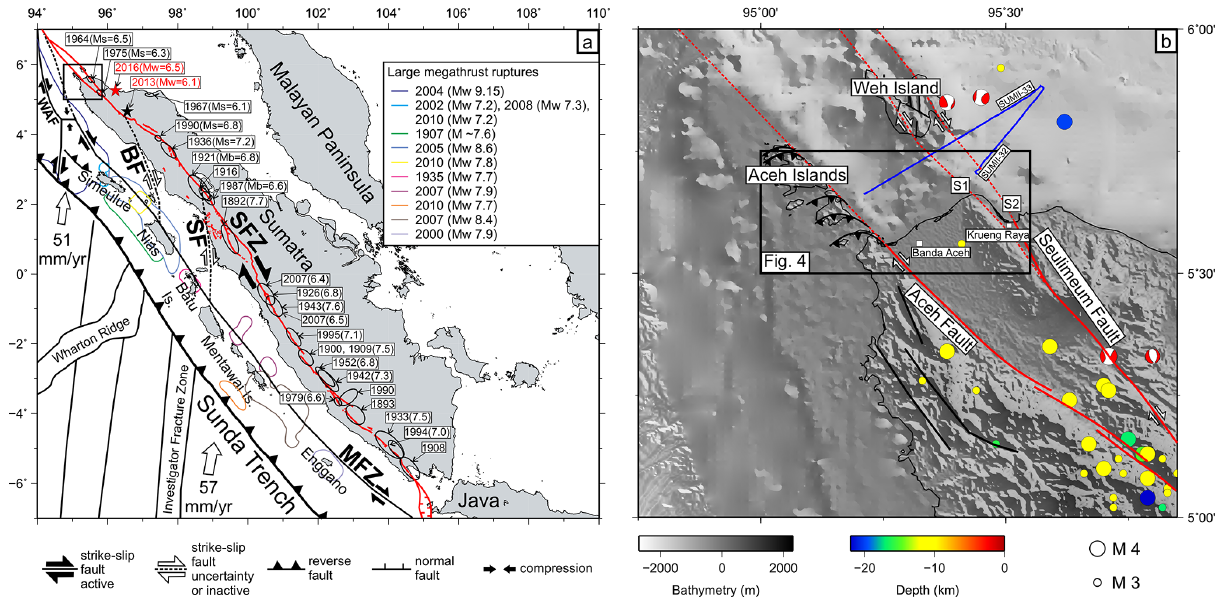
Figure 1. (a) Tectonics of the Sumatra subduction zone (Berglar et al., 2017). (b) Structure of the SFZ at northern Sumatra according to the interpretation of Fernández-Blanco et al. (2016). Recorded earthquake epicenters (color dots) and focal mechanisms were collected from the Badan Meteorologi, Klimatologi dan Geofisika (BMKG) of Indonesia and from the CMT global catalog (http://www.globalcmt.org/, last access: 26 July 2022),